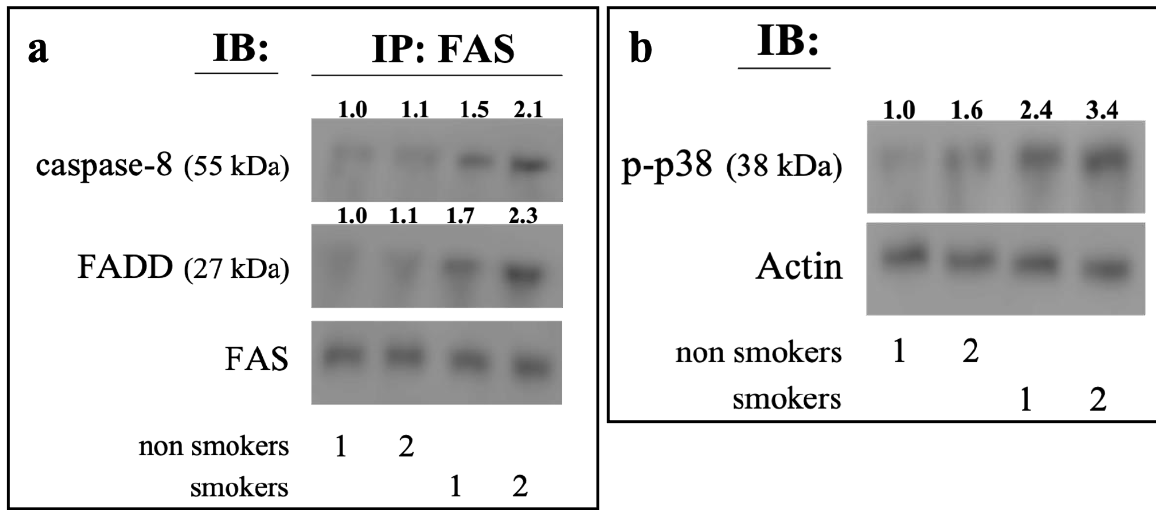
Figure 6. Fas-associated signaling complex and p-p38 MAPK levels in erythrocytes from smokers and healthy humans. RBCs isolated both from smokers and non-smokers volunteers were lysed and submitted either to immunoprecipitation with anti-Fas antibody ( a ) or to Western blot analysis of p-p38 MAPK ( b ). The IP were separated by SDS-PAGE and blotted with anti-FADD or anti-caspase-8. Blots were reprobed with anti-Fas ( a ) or anti-actin ( b ) antibody to ensure equal loading of the gels. The numbers below each line represent the relative expression level normalised to actin, as determined on the basis of the intensity of the band. Representative image of three experiments with similar results.